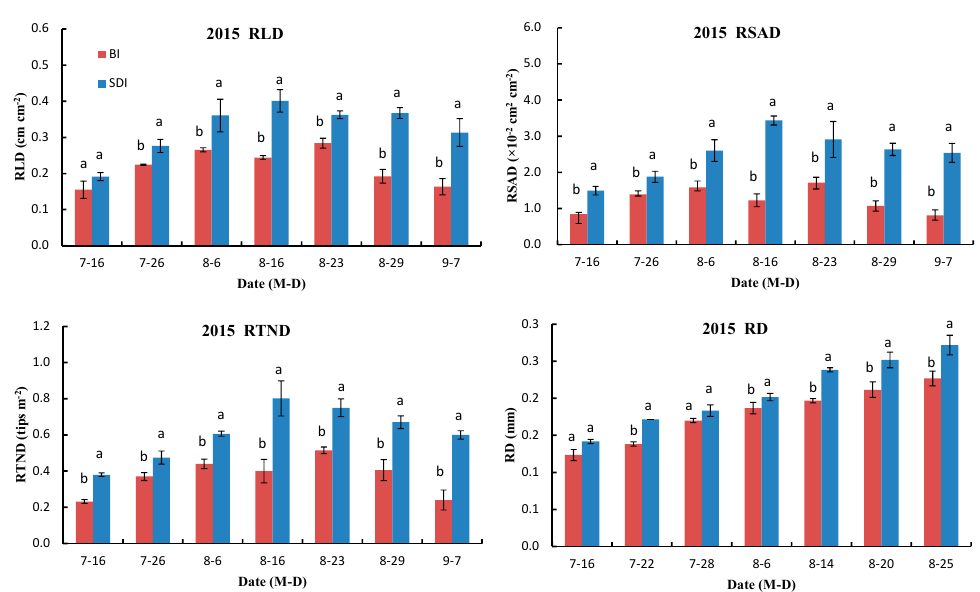
Figure 9. Variations in the RLD, RSAD, RTND and RD of transplanted cotton in 2015. Abbreviations: BI, border irrigation; SDI, surface drip irrigation; RLD, root length density; RSAD, root surface area density; RTND, root tip number density; and RD, root diameter. The vertical bars represent the standard errors of the means. Different lowercase letters indicate significant differences ( p < 5%) between the two treatments.